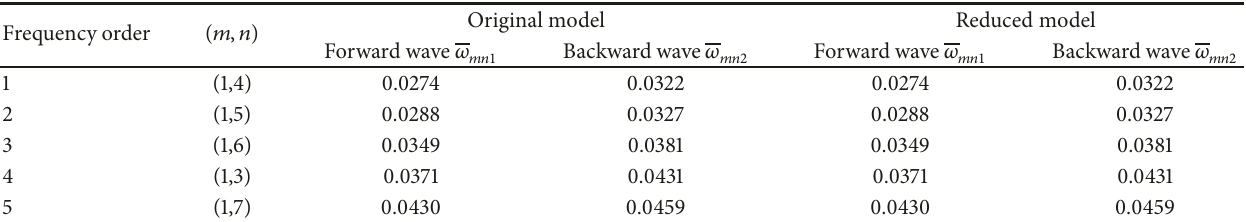
Figure 2: Natural frequencies versus the circumferential wave number ( 𝑚 =1): (a) Ω =0.005, (b) Ω =0.01. Table 3: Nondimensional frequency parameters of original model and reduced model ( Ω = 0.005 ).